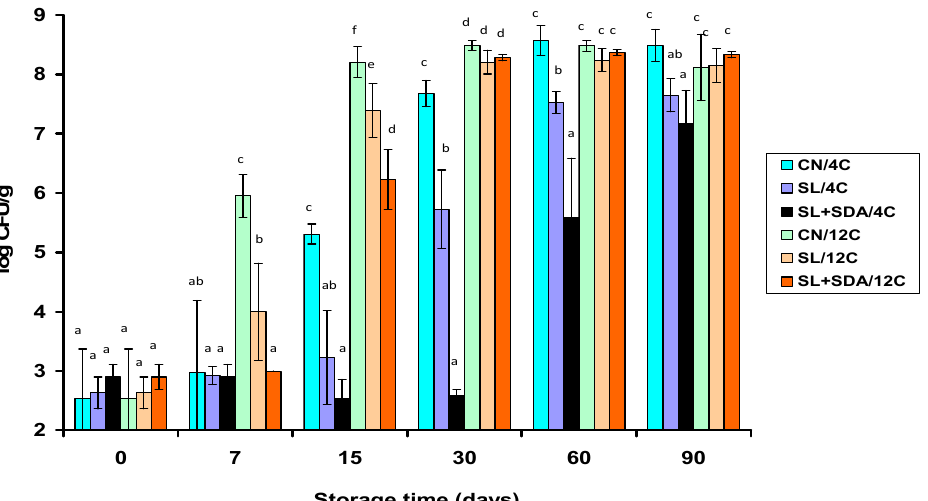
Figure 3. Mean total spoilage lactic acid bacteria (MRS agar/25 ◦ C) populations ( n = 4) grown on vacuum-packaged frankfurters during storage at 4 ◦ C and 12 ◦ C. Frankfurter treatments contained 1.8% sodium lactate (SL), or 1.8% SL and 0.25% sodium diacetate (SL + SDA). Frankfurters without preservatives served as controls (CN). Whiskers for each point value in the graph indicate standard deviations. Mean value bars within each sampling time interval bearing different lowercase letters are significantly different ( p < 0.05).